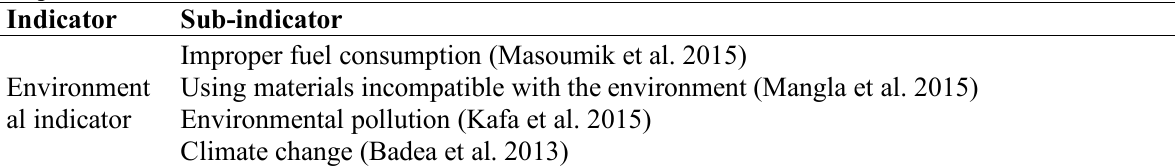
Table 1 . Indicators and sub-indicators for the risk and greenness of supply chain of tank construction adopted from relevant